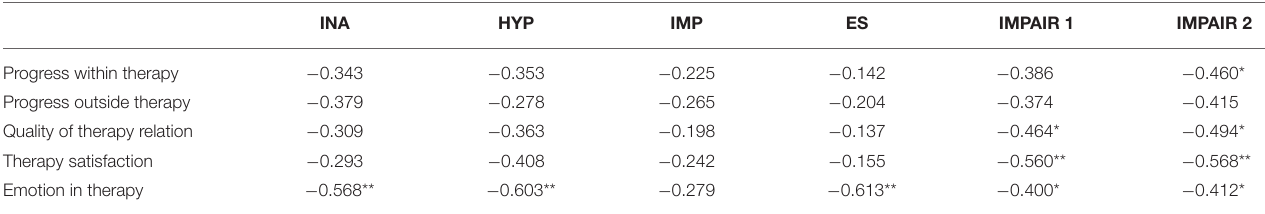
TABLE 5 | Spearman’s correlations between changes in core and emotional symptoms of ADHD, impairments and process characteristics of the CBT. INA HYP IMP ES IMPAIR